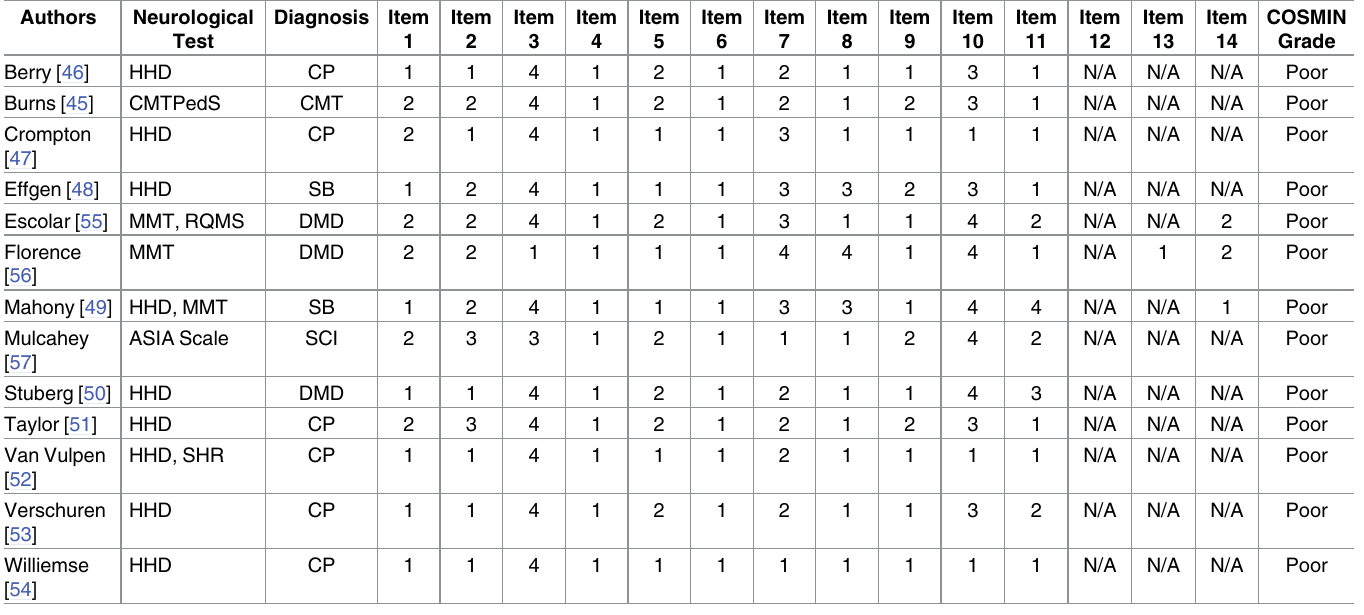
Table 4. COSMIN a reliability critical appraisal summaryof the methodological quality of the clinimetric papers. ( n = 15).